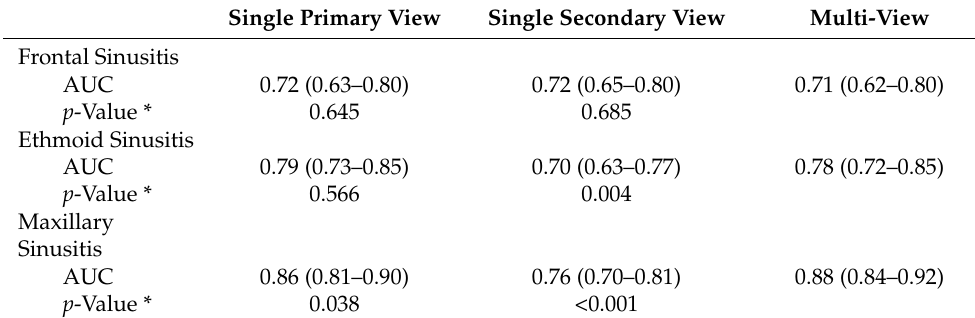
Table 2. Performance of deep learning model in diagnosing multiple sinusitis at each view.